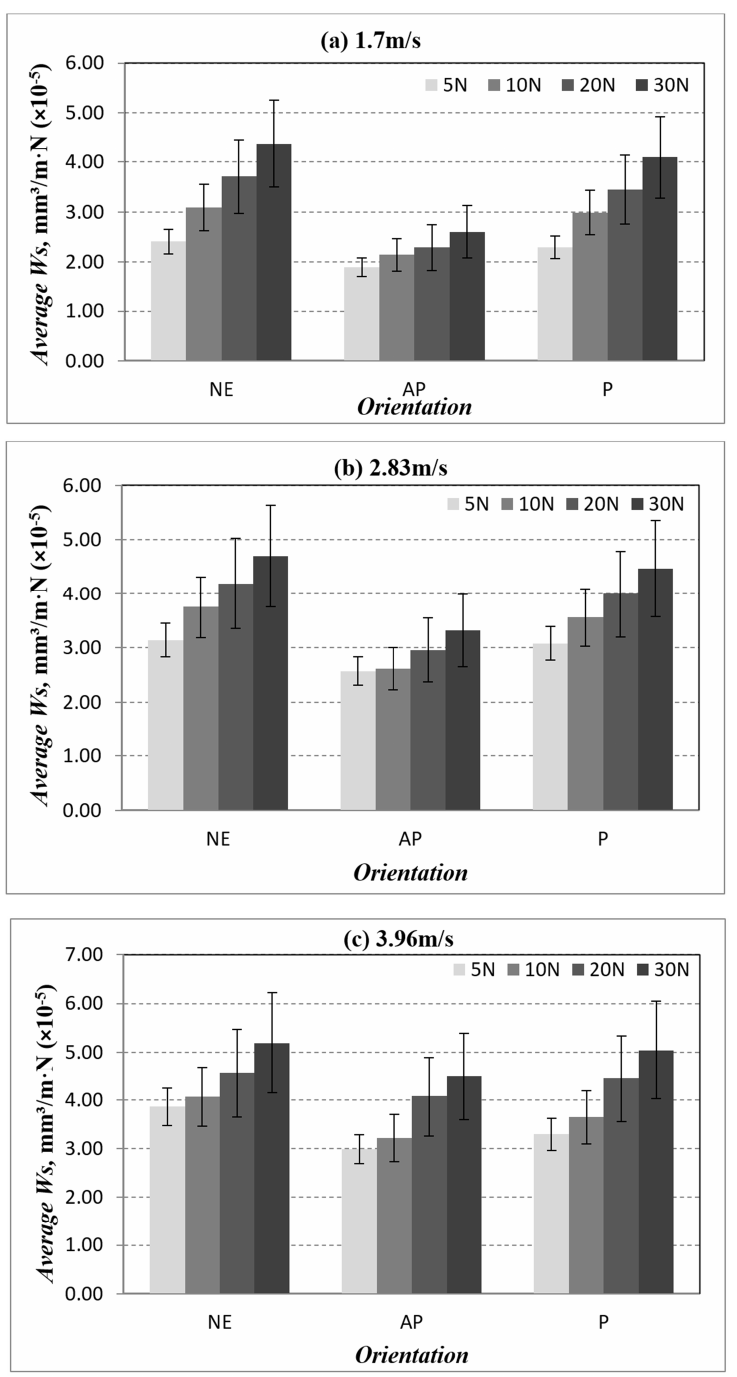
Figure 7. Average specific wear rate for different fibre orientation (AP and P) and neat epoxy subjected to different of applied normal load at different of sliding